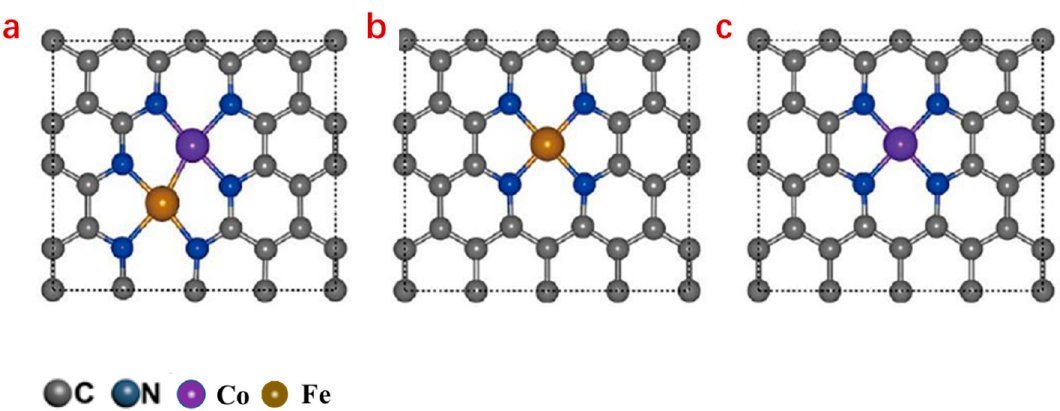
Figure 5. Structure comparison for dual-metal single-atom catalysts (SAC) ( a ; (Fe, Co–N x /C)) and mono-metal SACs ( b ; Fe–N x /C; c , Co–N x /C) [73].